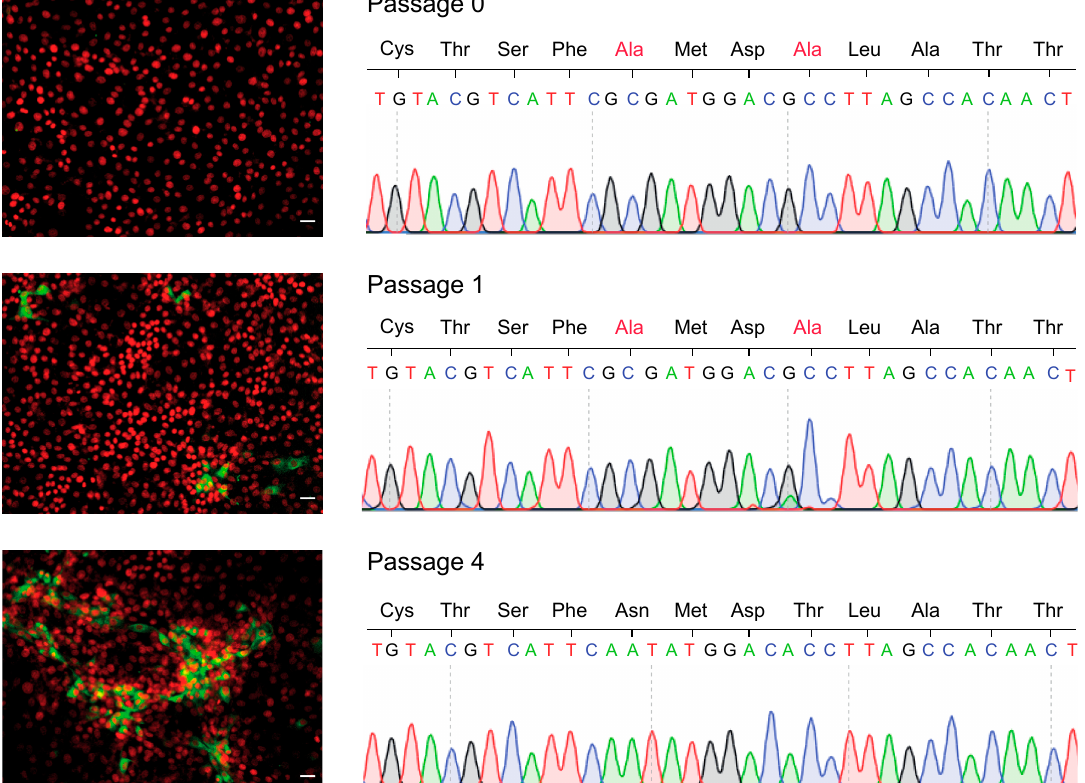
Figure 5. Reversion of mutations in the exposed β -hairpin motif restores BVDV infectivity. MDBK cells were transfected with the genomic RNA of the mutant virus and passaged every 3 days. The supernatant of transfected cells (Passage 0) and after one (Passage 1) or four passages (Passage 4) was used to infect fresh MDBK cells to follow the recovery of infectious viruses. (Left) Representative fluorescence microscopy images acquired with 10 × objective of infected MDBK cells stained with a polyclonal antibody against E2 (green channel) and DAPI (red channel). Scale bar: 10 µ m (Right) Sequence chromatogram of the 12 amino acid β -hairpin motif of viruses recovered in the cell culture supernatant at passages 0, 1 and